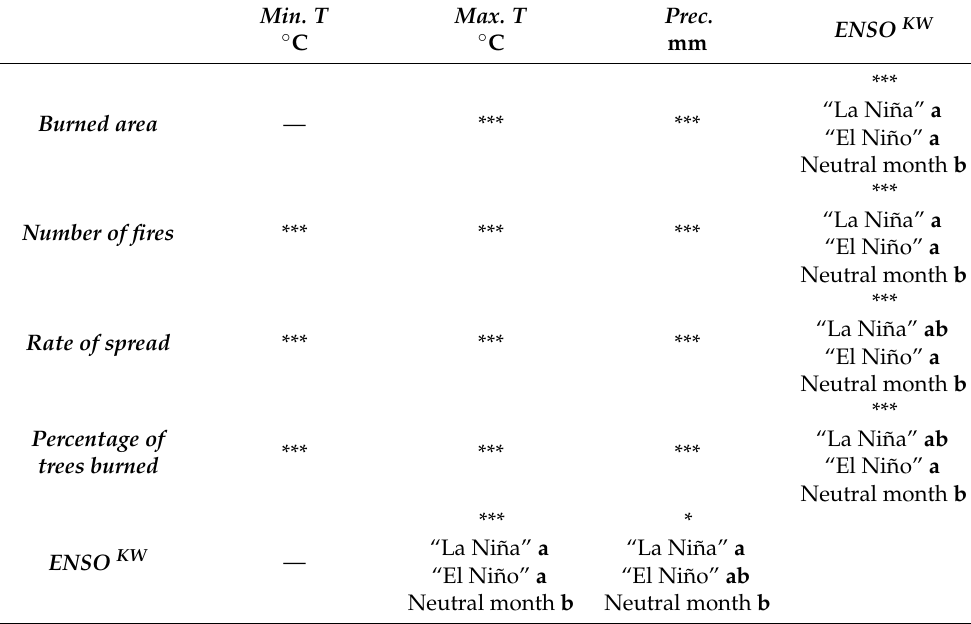
Figure 8. Fires during the 18-year period in MAB. “El Niño” and “La Niña” periods are indicated with yellow and red colors, respectively. Maximum and minimum temperatures showed as the margins of the ribbon. Table 2. Relationship between atmospheric variables and the fire records per month.